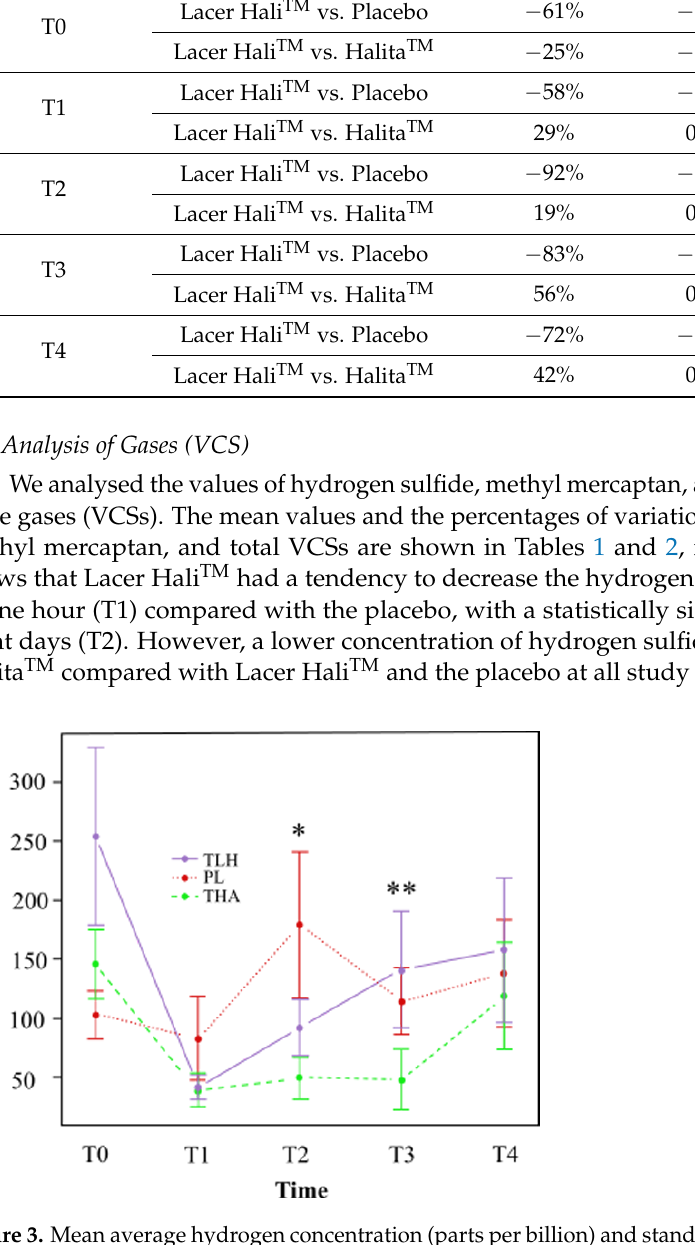
Figure 3. Mean average hydrogen concentration (parts per billion) and standard deviation at different time points (TLH, Lacer Hali TM treatment; PL, placebo; THA, Halita TM treatment). *: Statistically significant results ( p < 0.05) between the placebo and Lacer Hali TM groups were found. **: Statistically significant results ( p < 0.05) between the Lacer Hali TM and Halita TM groups were